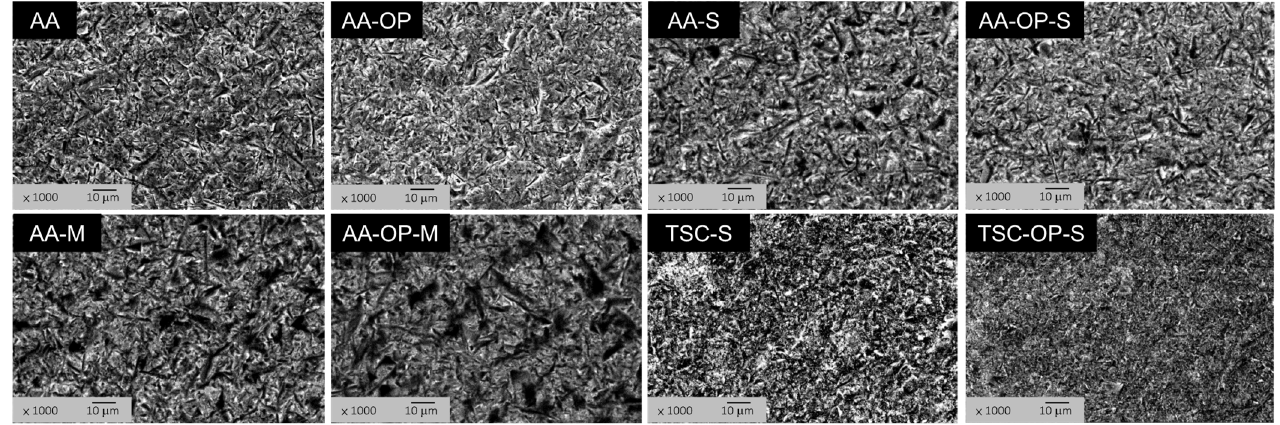
Figure 2. SEM images (1000×) after the surface treatment. Only TSC-OP-S showed an evident homogeneous coating on the grit-blasted surfaces.